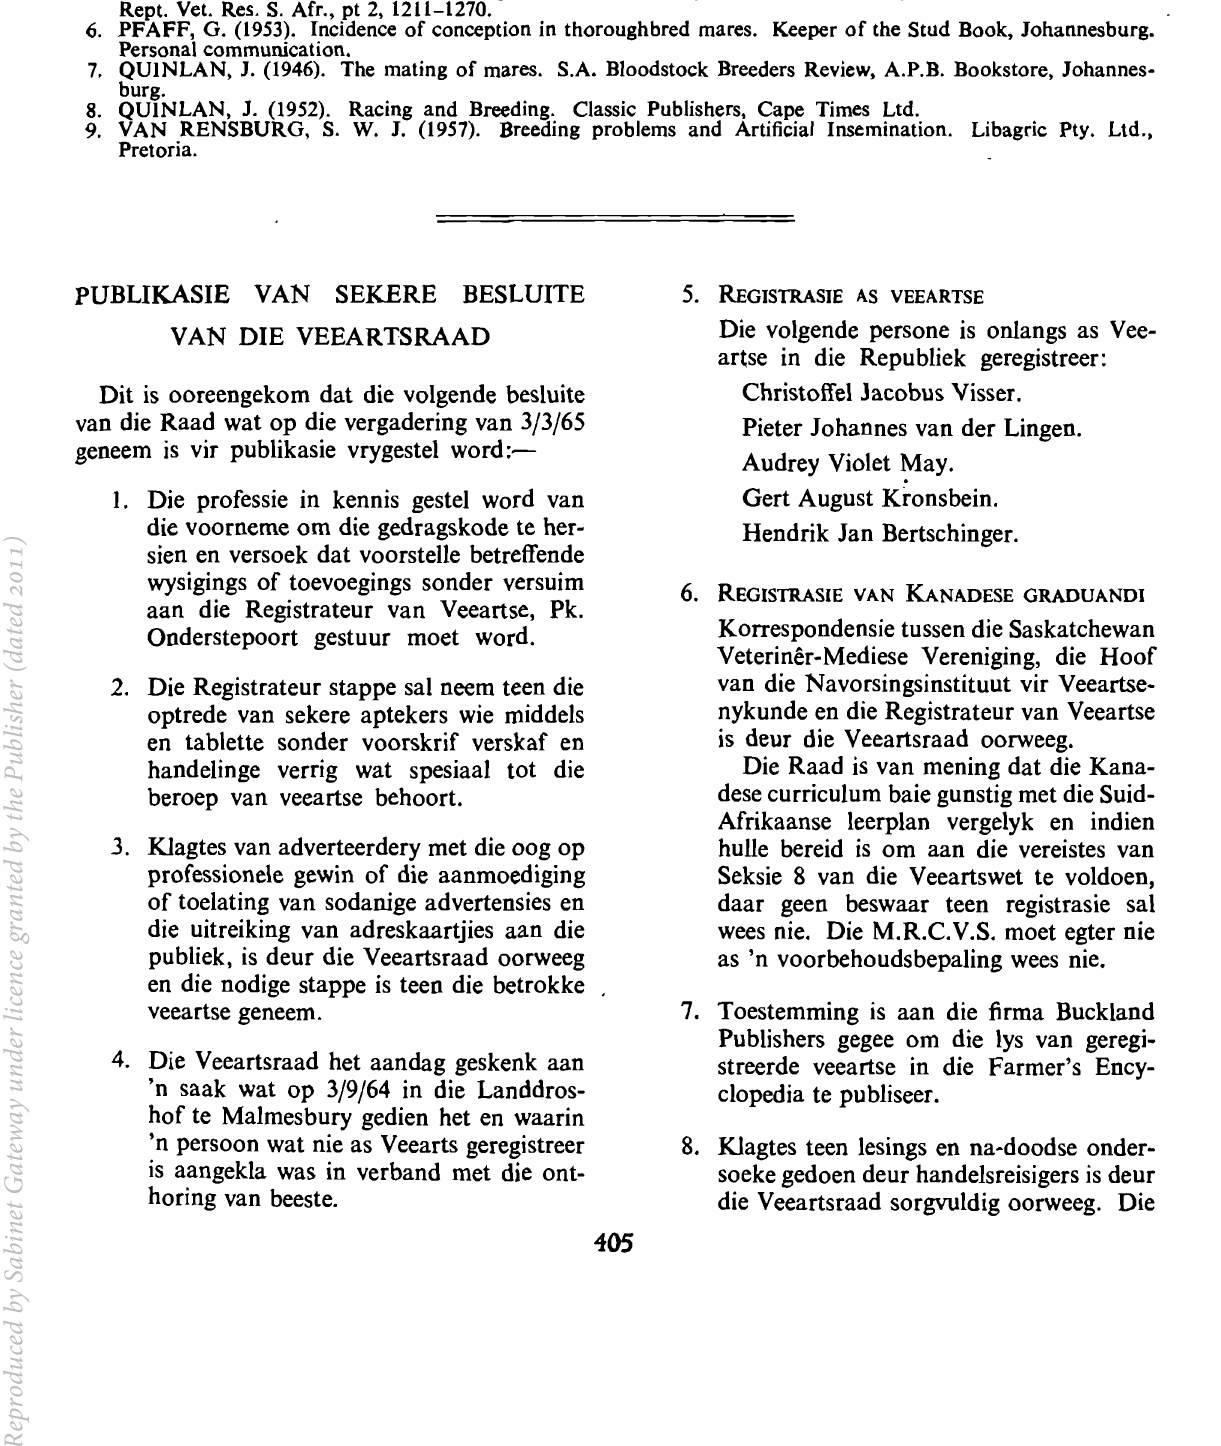
optrede van sekere aptekers wie middels en tablette sonder voorskrif verskaf en handelinge verrig wat spesiaal tot die beroep van veeartse